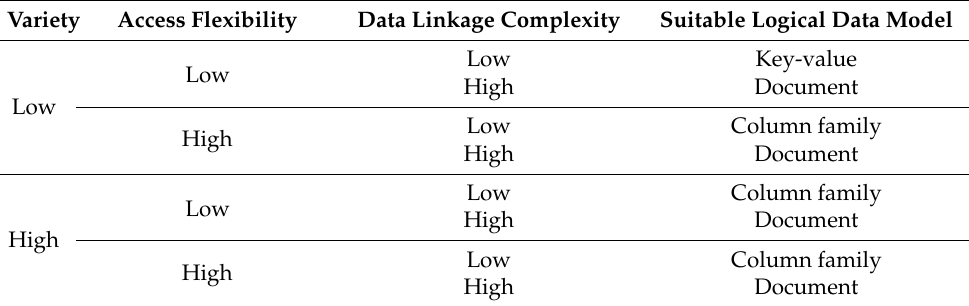
Table 4. Most suitable data model with BASE properties according to veracity, access flexibility, and data linkage